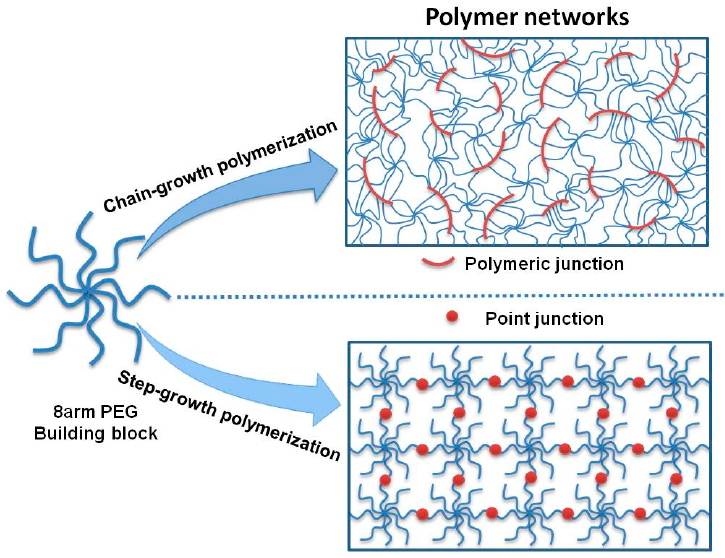
Figure 1. Schematic depiction of 8-arm polymer (as building block) networks structures obtained via chain-growth polymerization resulting in rigid polymeric junctions ( top ) and step-growth polymerization resulting in point junctions ( bottom ).